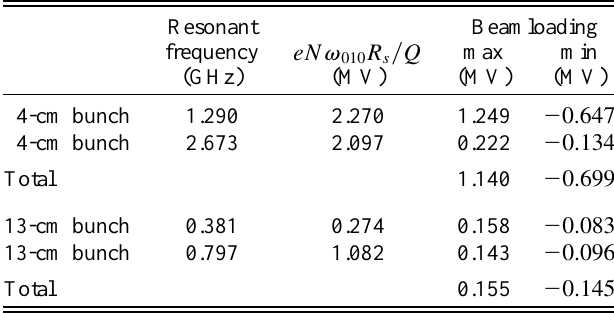
TABLE II. Beamloading voltages for the four compensating